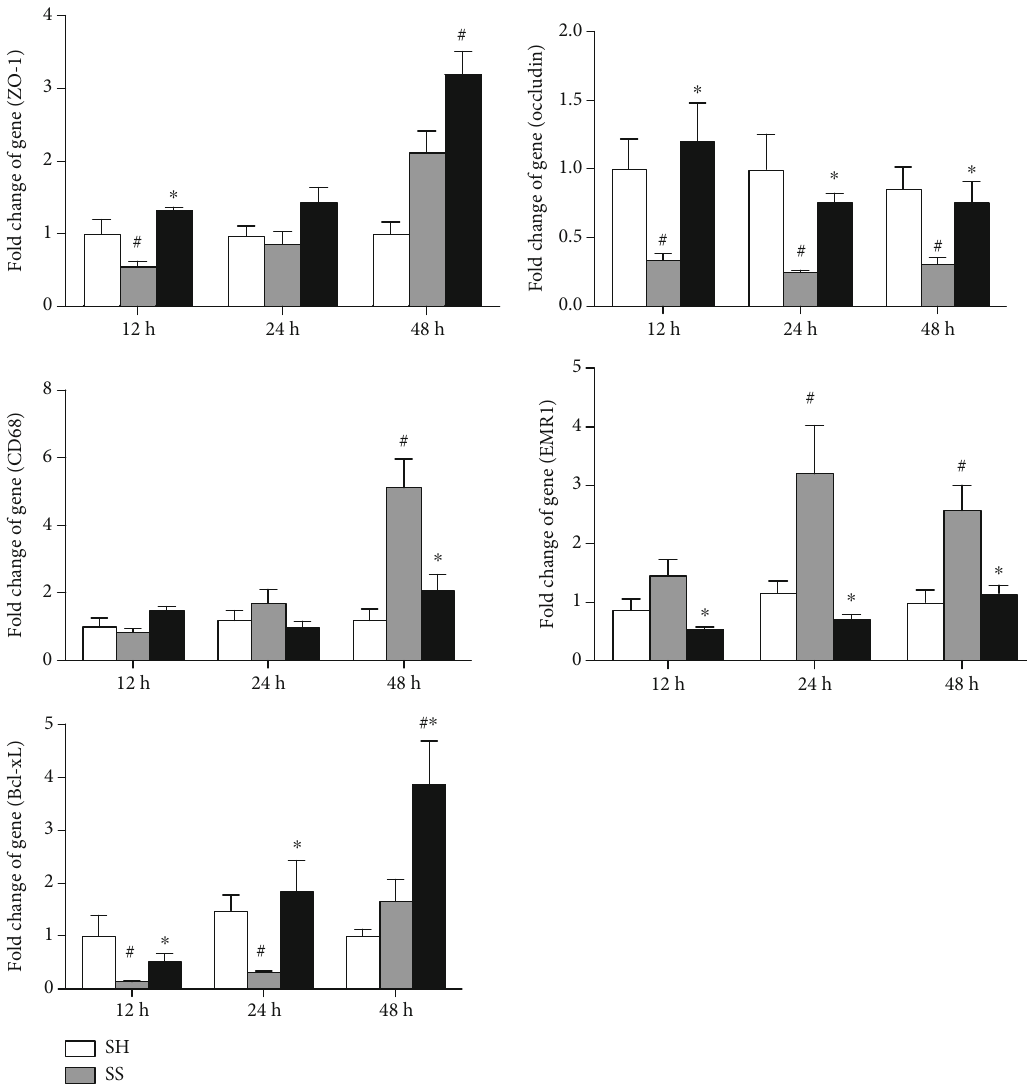
Figure 6: Expressions of genes related to macrophage in fi ltration, tissue injury, and antiapoptosis in the lungs. Cluster of di ff erentiation 68 (CD68), epidermal growth factor-like module-containing mucin-like hormone receptor-like (EMR)-1, zonula occludens (ZO)-1, and antiapoptotic marker B cell lymphoma-extra large (Bcl-xL). SH: sham-operated group; SS: sepsis group with saline; SG: sepsis group with glutamine. mRNA changes were quantitated and analyzed by a real-time PCR and calculated by the comparative CT (2 - ΔΔ Ct ) method. mRNA expression levels in the normal control group were used as a calibrator. Data are shown as the mean ± SEM . n = 8 for each group at 12, 24, or 48h after cecal ligation and puncture (CLP). Di ff erences among groups at each time point were analyzed by a one-way ANOVA followed by Tukey ’ s post-hoc test. The symbol “ # ” signi fi cantly di ff ers from the SH group; the symbol “ ∗ ” signi fi cantly di ff ers from the SS group ( p < 0 : 05